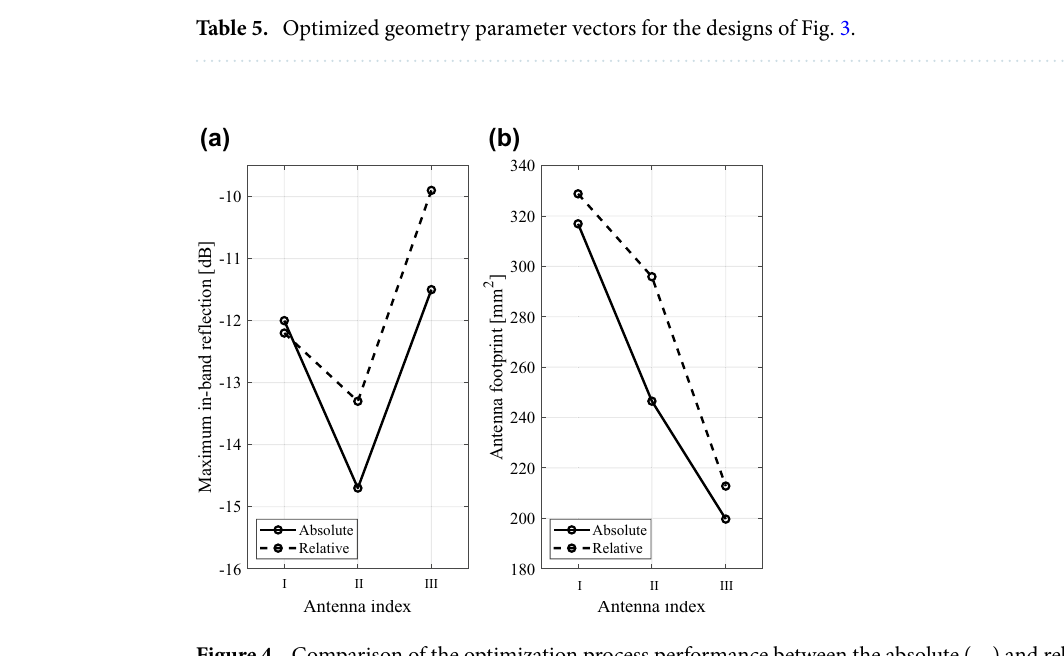
Figure 4. Comparison of the optimization process performance between the absolute (—) and relative (- - -) antenna parameterization. Shown are: (a) the maximum in-band reflection of the antenna, averaged over the ten independent optimization runs (optimization for matching improvement), and (b) antenna footprint area averaged over the ten independent optimization runs (optimization for size reduction). Consistent differences between the two parameterization can be observed, in favor of relative parameterization when optimizing for matching improvement, and absolute parameterization when optimizing for size reduction. (Matlab R2016a https:// www. mathw orks.